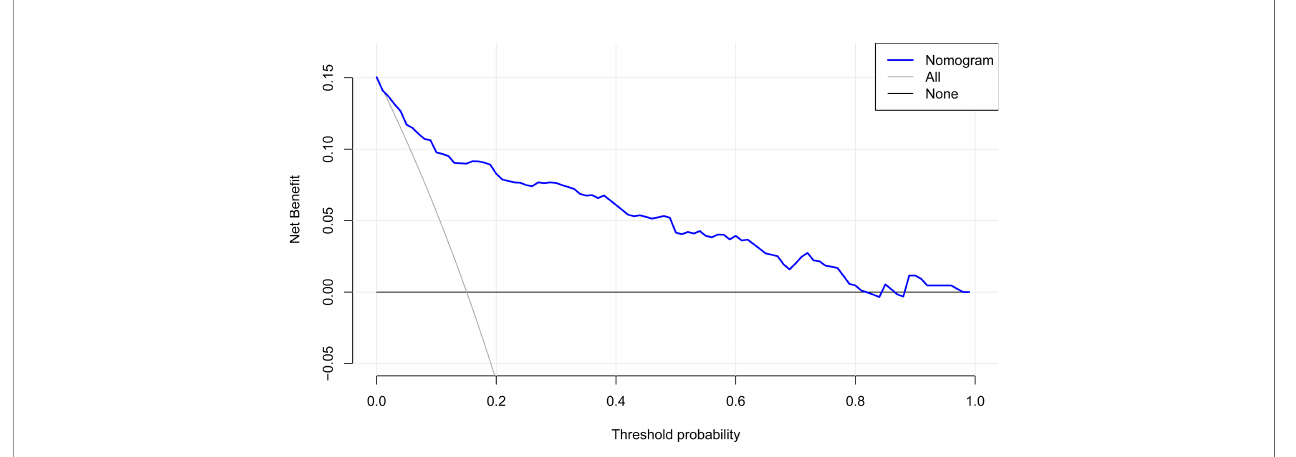
FIGURE 6 | DCA of the nomogram. It indicates that the nomogram yields clinical net bene fi t when the threshold probability is < 0.8. DCA, decision curve